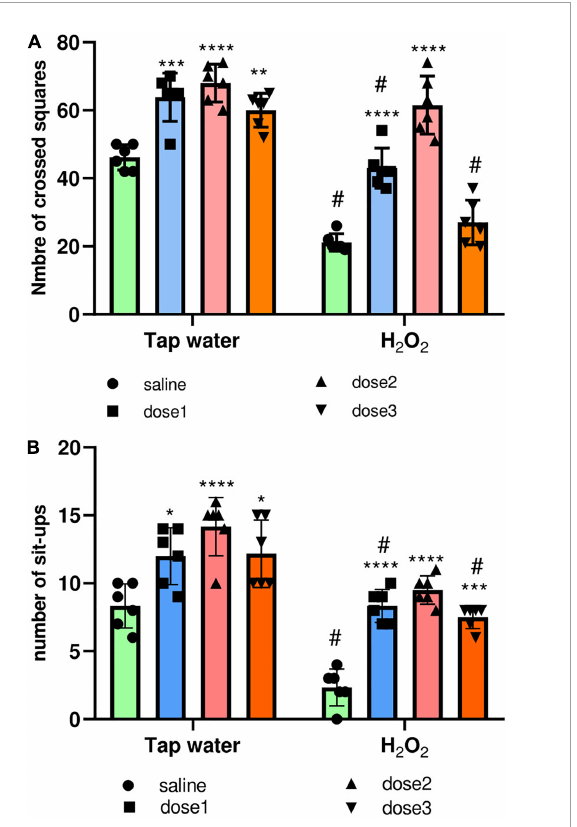
FIGURE4 Effect of the interaction between the extract treatment and the exposure to H 2 O 2 on locomotion assessed by the OF test. (A) The distance crossed by animals defined by the number of squares. (B) The number of animals’ sit-ups. The results were presented as mean ± SD ( n = 6). Data were analyzed by Two-ways ANOVA followed by Bonferroni’s post-hoc test; * p ≤ 0.05, ** p ≤ 0.01, *** p ≤ 0.001, **** p ≤ 0.0001 compared to saline group in the same treatment conditions. (#) in comparison with the control group (group